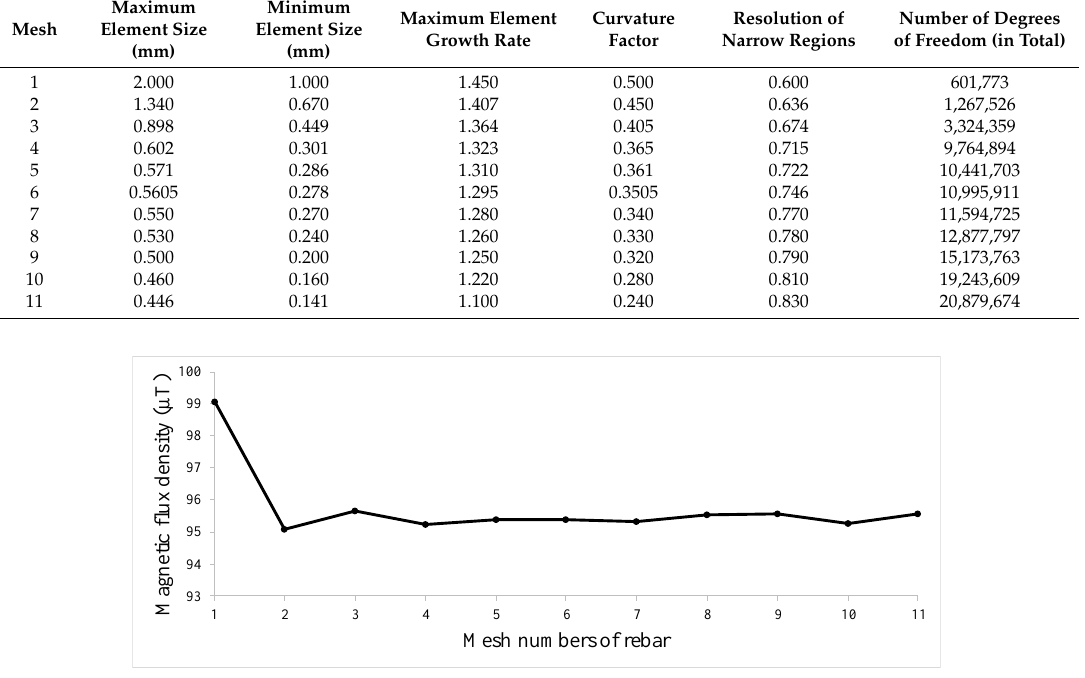
Figure 7. Maximum values of Z-component magnetic flux density, from 295.0592 mm to 307.0592 mm (values related to Hole 2), for different mesh specifications of rebar with fixed box mesh #1.